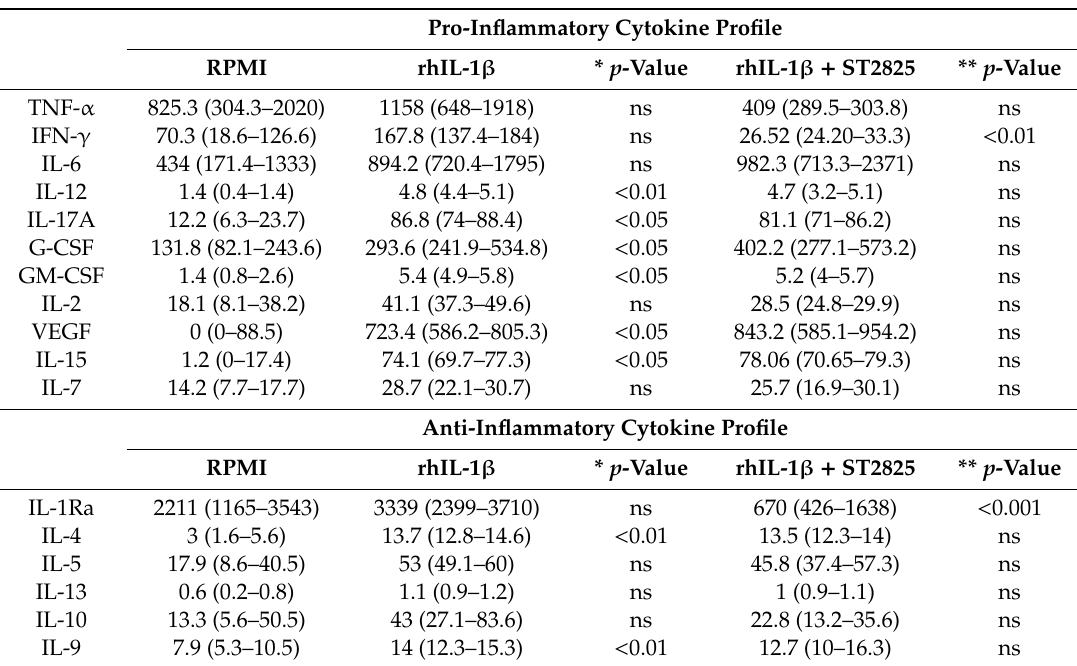
rhIL-1 β plus ST2825). Not significant (ns). Abbreviations: IL, interleukin; TNF- α , tumor necrosis factor alpha; IFN- γ , interferongamma; G-CSF,granulocytecolony-stimulatingfactor; GM-CSF,granulocyte-monocytecolony-stimulating factor; VEGF, vascular endothelial growth